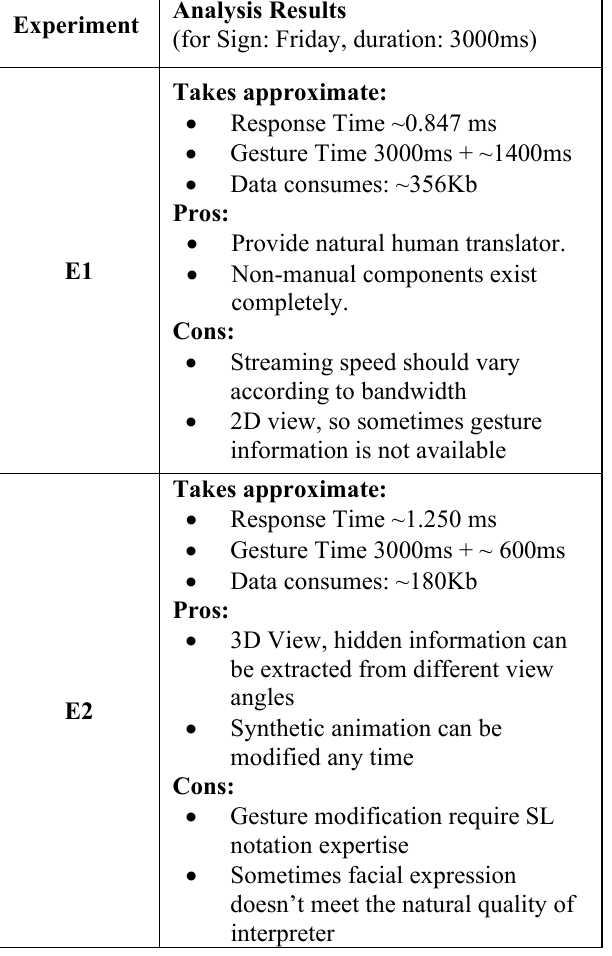
Table 1. Experiment results to analyse performance